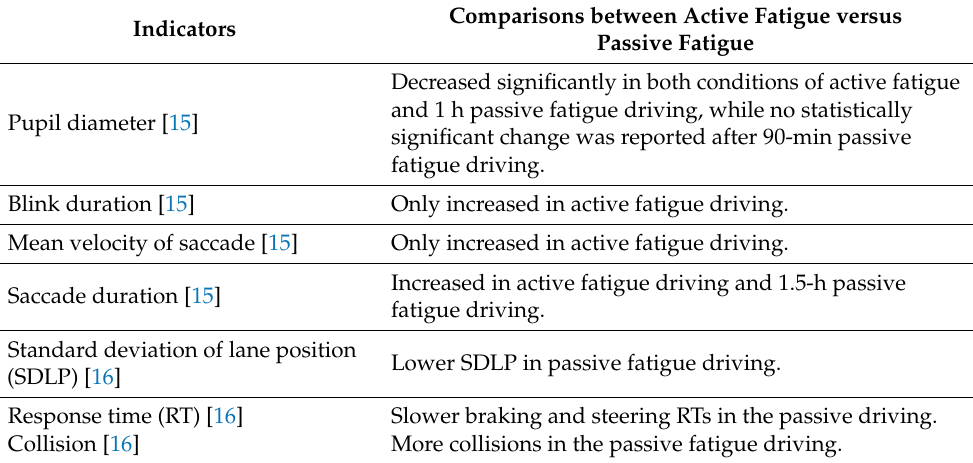
Table 1. Comparisons of physiological and behavioral indicators for active fatigue versus passive fatigue.